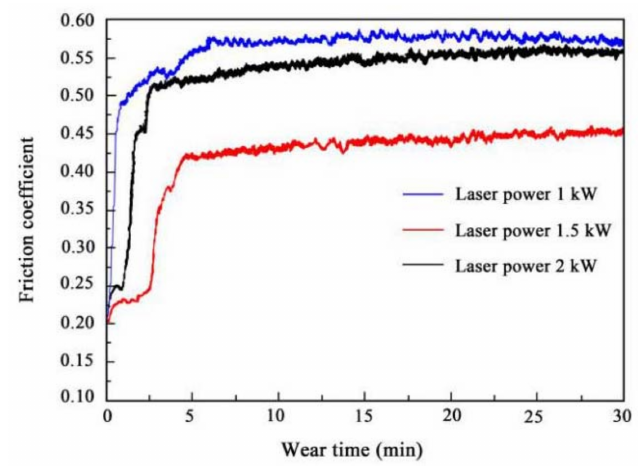
Figure 7. Friction coefficients of Ni/TiN coatings produced at various laser powers.